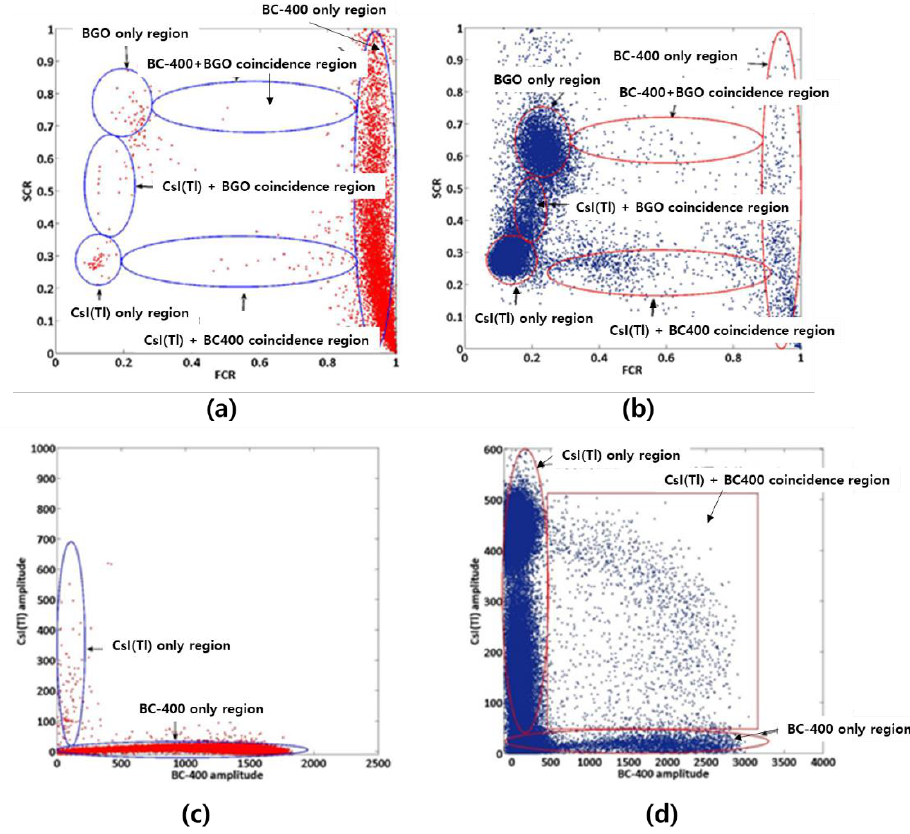
Figure 24. The results calculated by the FCR–SCR method ( a , b ) and the least-squares method ( c , d );